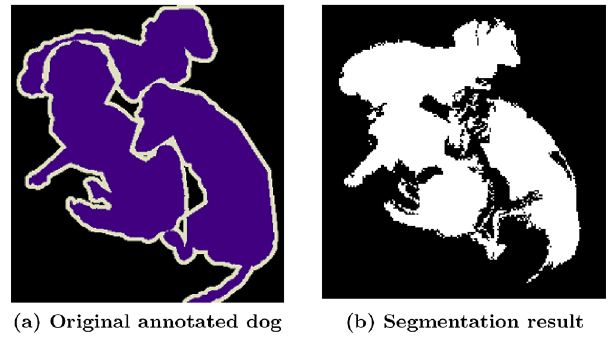
Fig. 9 Annotated and respective segmentation result for dog from VOC2012 challenge datasets using proposed method.